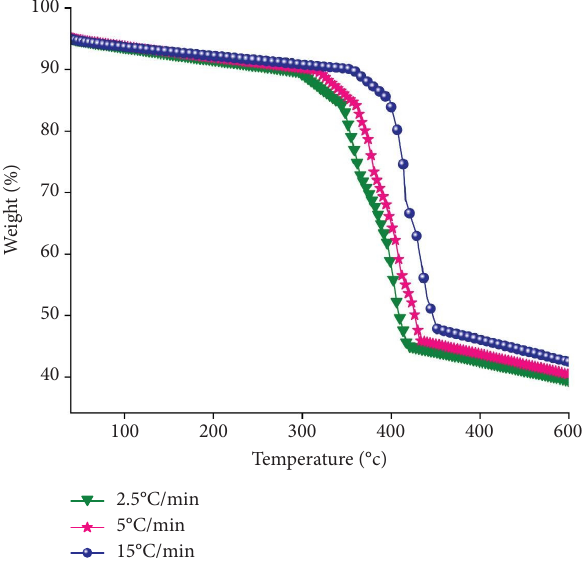
Figure 6: TGA curves of ACM-CB60-HNT6 composites at dif- ferent heating rates under nitrogen atmosphere.